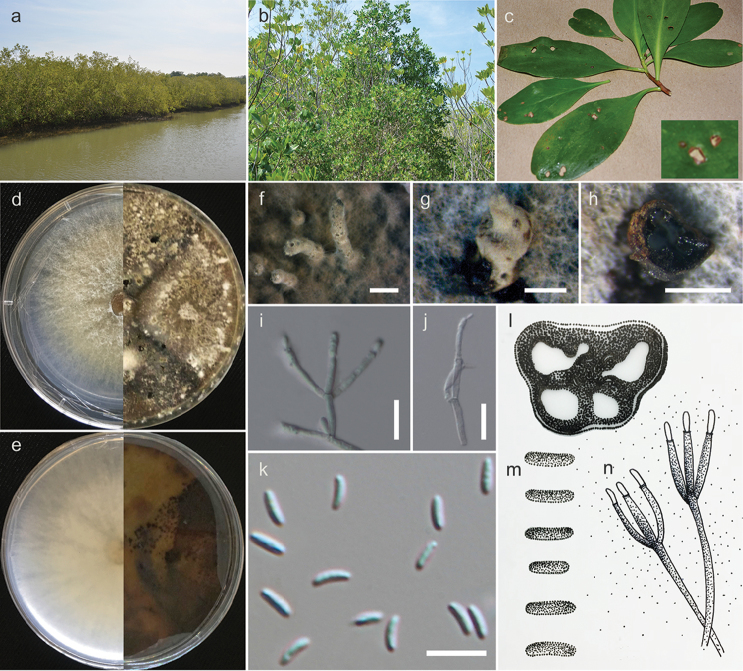
Cytosporalumnitzericola (MFLUCC 17-0508, from culture). a Mangrove collecting site b, cLumnitzeraracemosa in mangroves forest d, e Colonies on MEA after 6 days (left) and 30 days (right) (d-from above, e-from below) f, gConidiomata produced on MEAh, l Transverse sections of conidioma i, j, n Conidiogenous cells with attached conidia k, mConidia. Scale bars: f = 1000 µm, g, h = 500 µm, i, j = 10 µm, k = 5 µm.